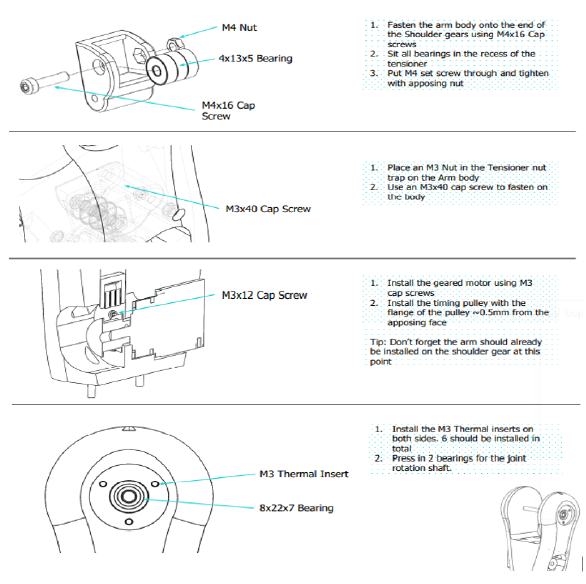
Fig. 5. Design for arm assembly